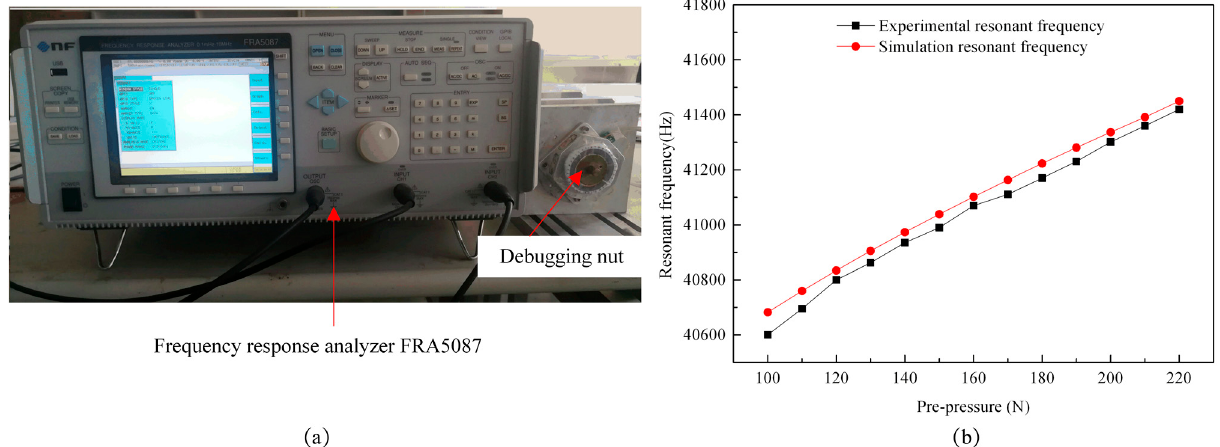
Figure 25. Resonance frequency measurement diagram with prepressure: ( a ) a resonance frequency test kit diagram with prepressure; and ( b ) a comparison diagram of the experimental test results and theoretical calculation results with the change in prepressure.